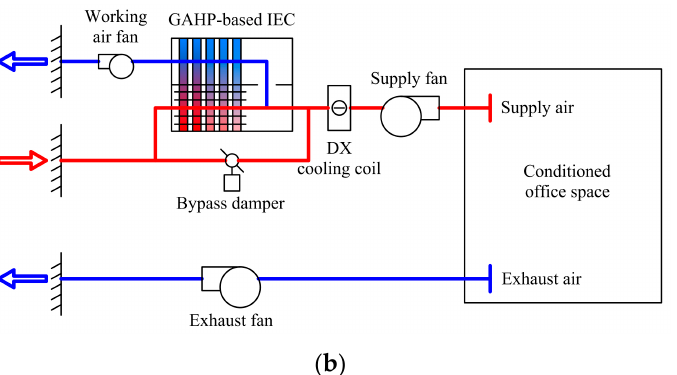
Figure 2. The schematic of the investigated hybrid air conditioning systems: ( a ) System 1 (rotary heat exchanger and DX cooling coil); ( b ) System 2 (GAHP-based IEC and DX cooling coil).